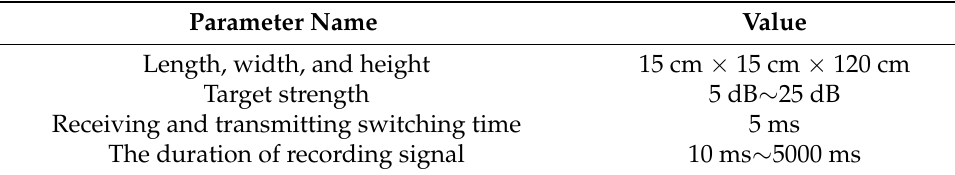
Table 5. Parameters of target